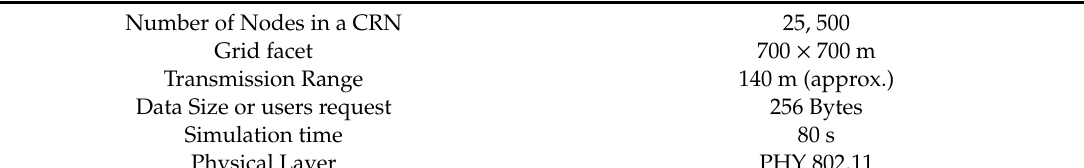
Table 1. Parameters.